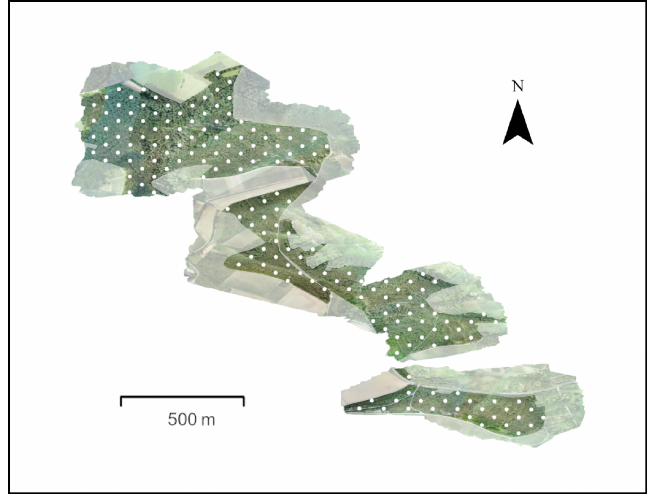
Figure 2. Virtual sample plots (white) on all 27 UAV-based orthomosaics of the study area (saturated).